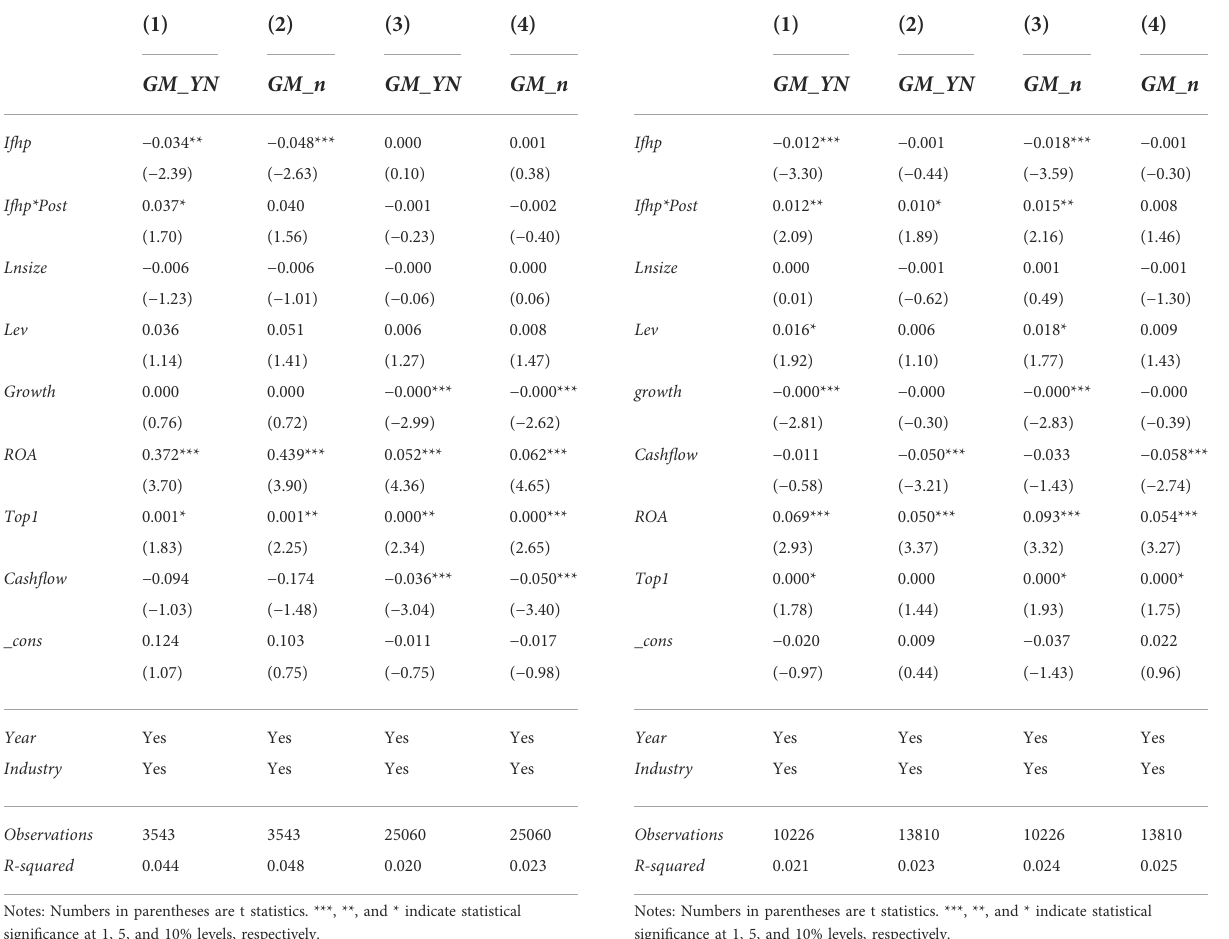
TABLE 5 Robustness tests. TABLE 6 Heterogeneity test for